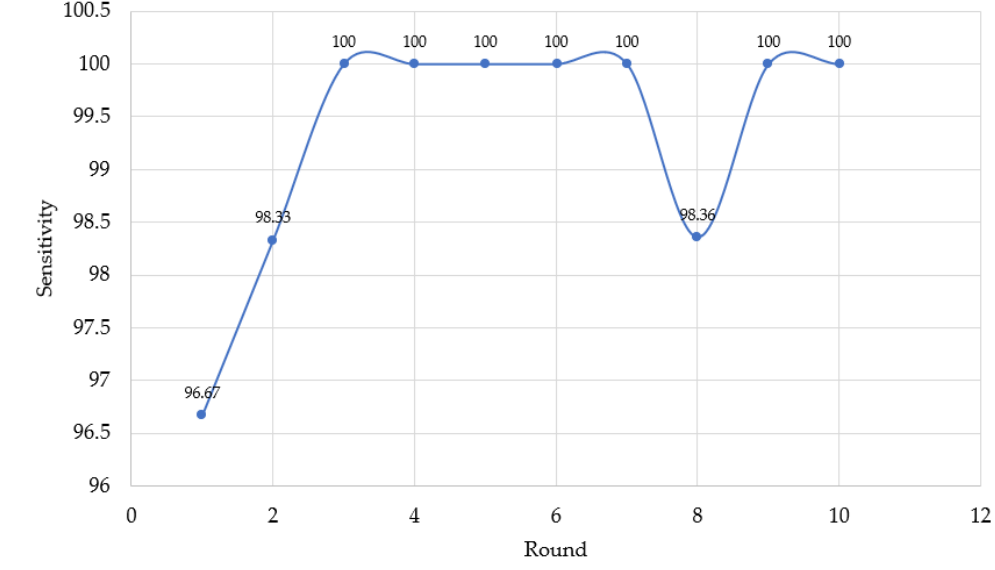
Figure 32. Sensitivity in human motion